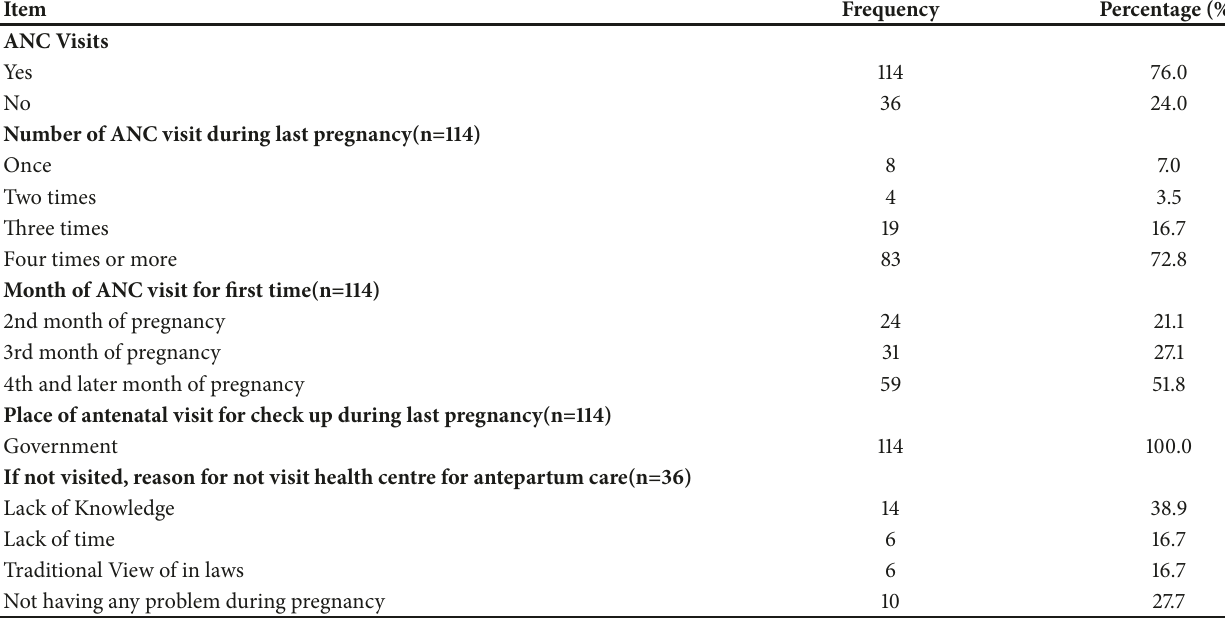
Table 2: ANC visits for pregnancy checkups.